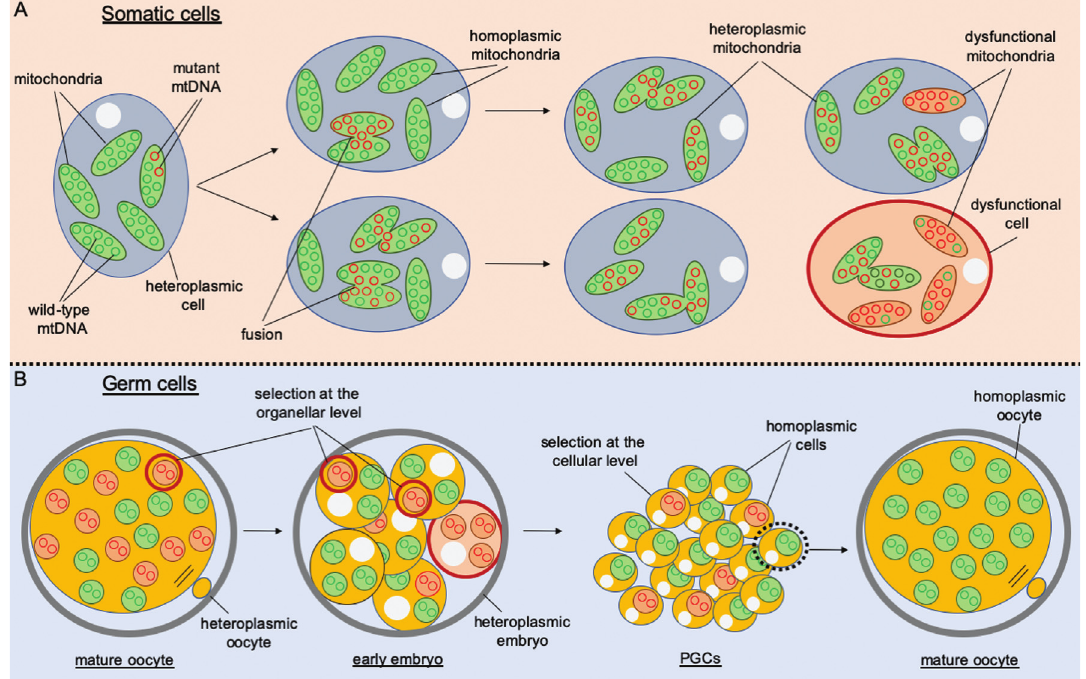
Figure 2 - Mitochondrial DNA inheritance in somatic and germ cells. Different mitochondria in a single somatic cell (A) are interconnected by constant events of fusion and fission, allowing them to share membranes, solutes, metabolites, proteins, RNAs and DNA (mitochondrial DNA – mtDNA). Hence, when a mutation in mtDNA arises, it can rapidly spread throughout the mitochondrial network. In this case, mutant (red circles) and wild-type (green cir- cles) mtDNAs may co-exist, which is known as heteroplasmy. In comparison, homoplasmic mitochondria contain a single mtDNA genotype, either mu- tant or wild-type. Unless the mutation level exceeds a critical threshold necessary to cause a biochemical defect (i.e., above 60-90%; red mitochondria), the mutation effect will be masked by wild-type molecules (green mitochondria with both mutant and wild-type mtDNA). In germ cells (B), downregulation of fusion likely minimizes heteroplasmy within mitochondria, enhancing selection at the organellar level (i.e, stronger association be- tween mitochondrial genotype and phenotype). In addition, decreased fusion leads to mitochondrial fragmentation, enhancing mtDNA segregation among embryonic cells. Hence, decreased levels of mtDNA in primordial germ cells (PGCs) makes possible selection at the cellular level (i.e., stronger association between mitochondrial genotype and cellular phenotype). Thus, as a result of selection against deleterious mutations, mature oocyte from the next generation may contain lower levels of mutant